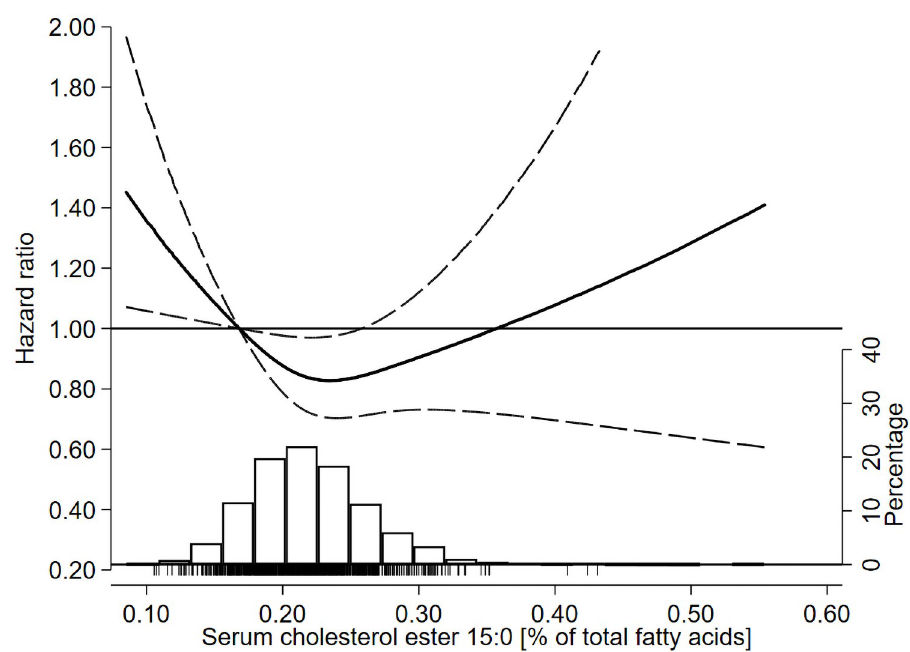
Fig 2. HRs of all-cause mortality as a function of serum pentadecanoic acid (15:0) in the 60YO study. Data were fitted using Cox regression models adjusted for baseline age, sex, BMI, alcohol intake, smoking habits, physical activity, education, and prevalent hypertension, hyperlipidaemia, type 2 diabetes, and CVD. Dashed lines represent 95% confidence limits. The reference value of serum 15:0 is the 10th percentile (i.e., 0.17% of total fatty acids). The histogram shows the distribution of serum 15:0 in the cohort and the tick marks under the histogram indicate serum 15:0 levels of individuals who died during follow-up. CVD, cardiovascular disease; HR, hazard ratio.